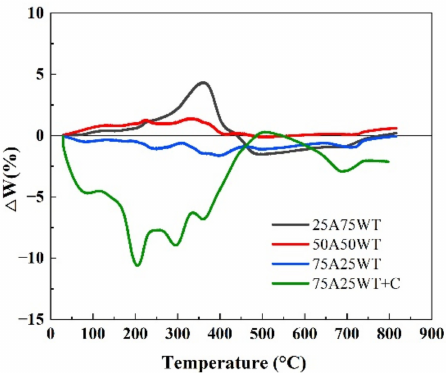
Figure 5. The fluctuation of ∆ W for the blends at 25 ◦